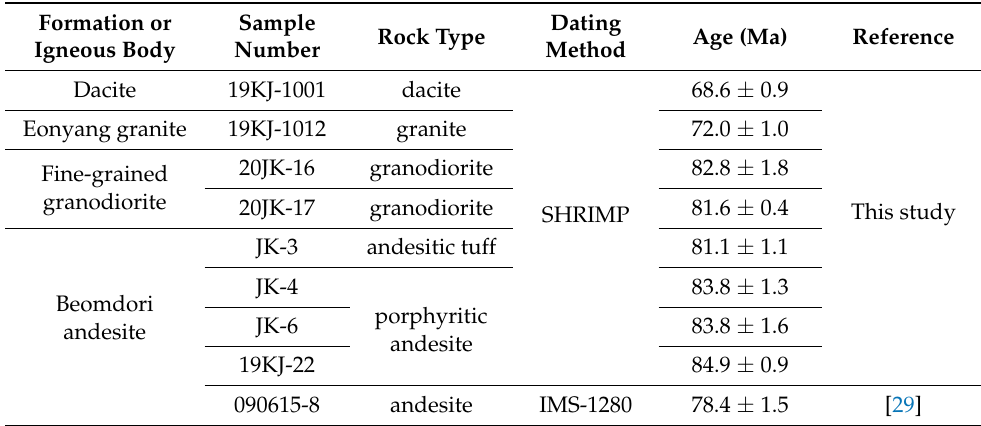
Figure 22. Simplified lithological sequence based on the geochronology of the study area. Table 2. SHRIMP and SIMS zircon age dating results for the igneous rocks of the study